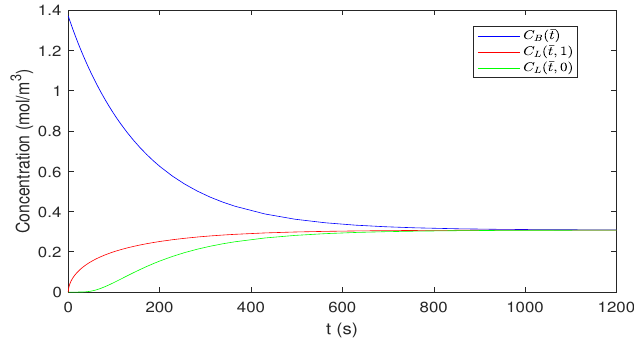
Figure 6. Dynamics of the concentrations obtained from the simplified model for the data reported in